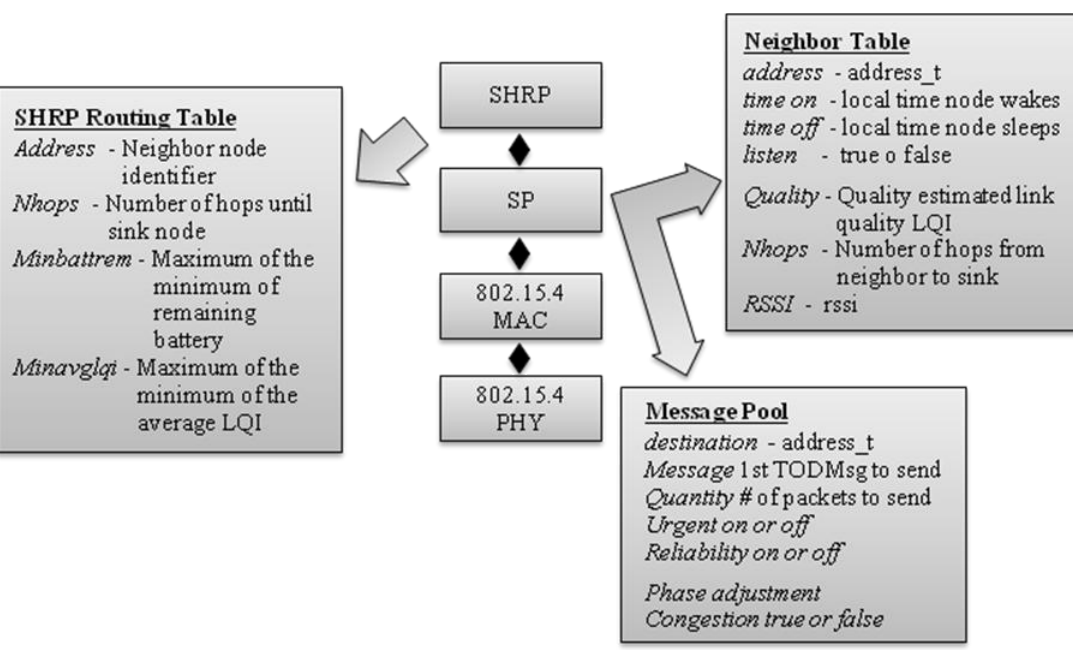
Figure 2. Interaction between SHRP protocol and